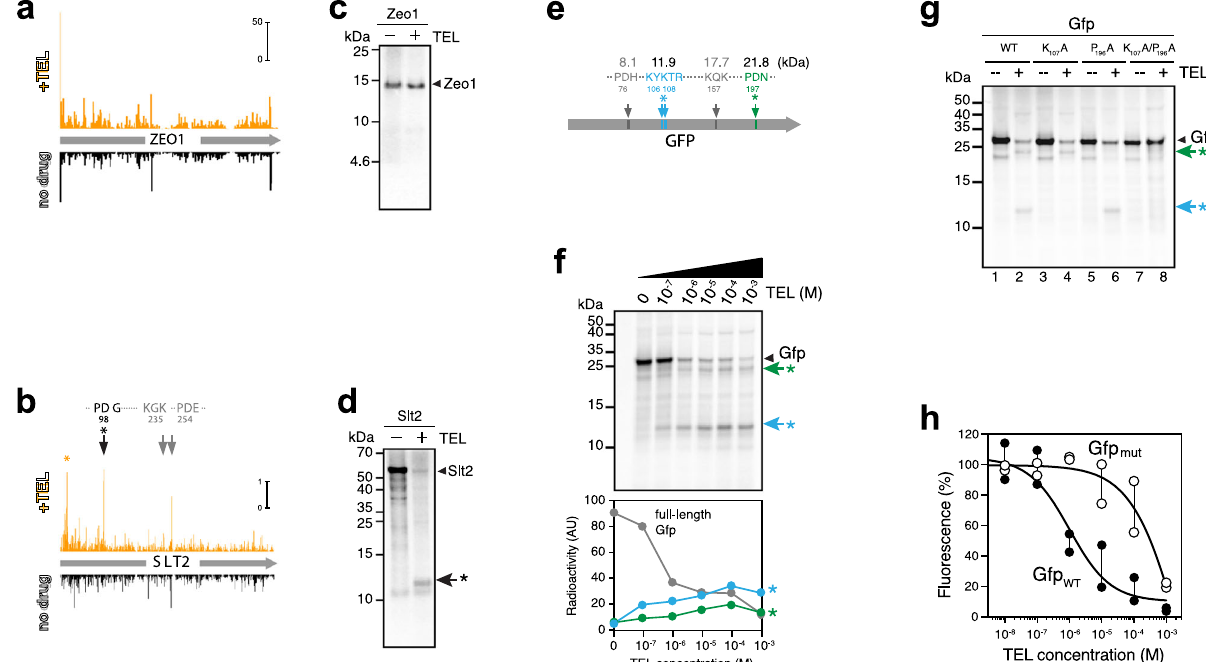
Fig. 5 TEL selectively inhibits in vitro translation of proteins with speci fi c sequence motifs. a, b Ribosome footprint density in the ZEO1 ( a ) and SLT2 ( b ) genes in yeast cells treated (orange plots) or not (black plots) for 10 min with 8× MIC of TEL. PDX and + X + motifs present in the SLT2 gene are indicated by arrows. Increased ribosome occupancy at early codons of SLT2 (orange asterisk) occurs at sites not conforming to the + X + or PDX motifs. c, d SDS-gel analysis of the [ 35 S]-radiolabeled proteins generated by in vitro translation of the ZEO1 ( c ) or SLT2 ( d ) templates by the G2400A yeast ribosome in the absence of the drug or in the presence of 100 µ M TEL. Arrowheads indicate full-size proteins. The truncated Slt2 polypeptide, likely a product of TEL- mediated translation arrest at the PD 98 G motif, is indicated by an arrow and asterisk. e Locations of + X + and PDX motifs in the GFP reporter gene. The molecular weights (kDa) of the proteins whose translation would be terminated at the corresponding sites are indicated. f Top: SDS-gel analysis of the [ 35 S]-labeled products of in vitro translation of the GFP template in the absence or presence of increasing concentration of TEL. The band of the full-size Gfp is indicated. Truncated Gfp polypeptides resulting from TEL-induced ribosome arrest are marked with arrows and asterisks (colored as shown in e . Bottom: quanti fi cation of the relative radioactivity associated with the full-size and truncated Gfp polypeptides in the SDS gel above. g SDS-gel analysis of the in vitro translation products of the wild-type (WT) GFP gene or its mutant variants in the absence or presence of 100 µ M TEL. Translation products are labeled as in f . h Expression of wt Gfp (Gfp wt ) or its K 107 A/P 196 A mutant (Gfp mut ) in the yeast cell-free translation system in the presence of increasing concentrations of TEL. Accumulation of functional Gfp was followed by its fl uorescence. The activity of Gfp wt in the “ no-drug ” samples was set at 100%. The curves represent average of two independent experiments with individual data points indicated by fi lled (Gfp wt ) or open (Gfp mut ) circles. The uncropped gel can be found in the Source data fi le. The results shown in c , d , f , and g are typical representatives of at least two independent